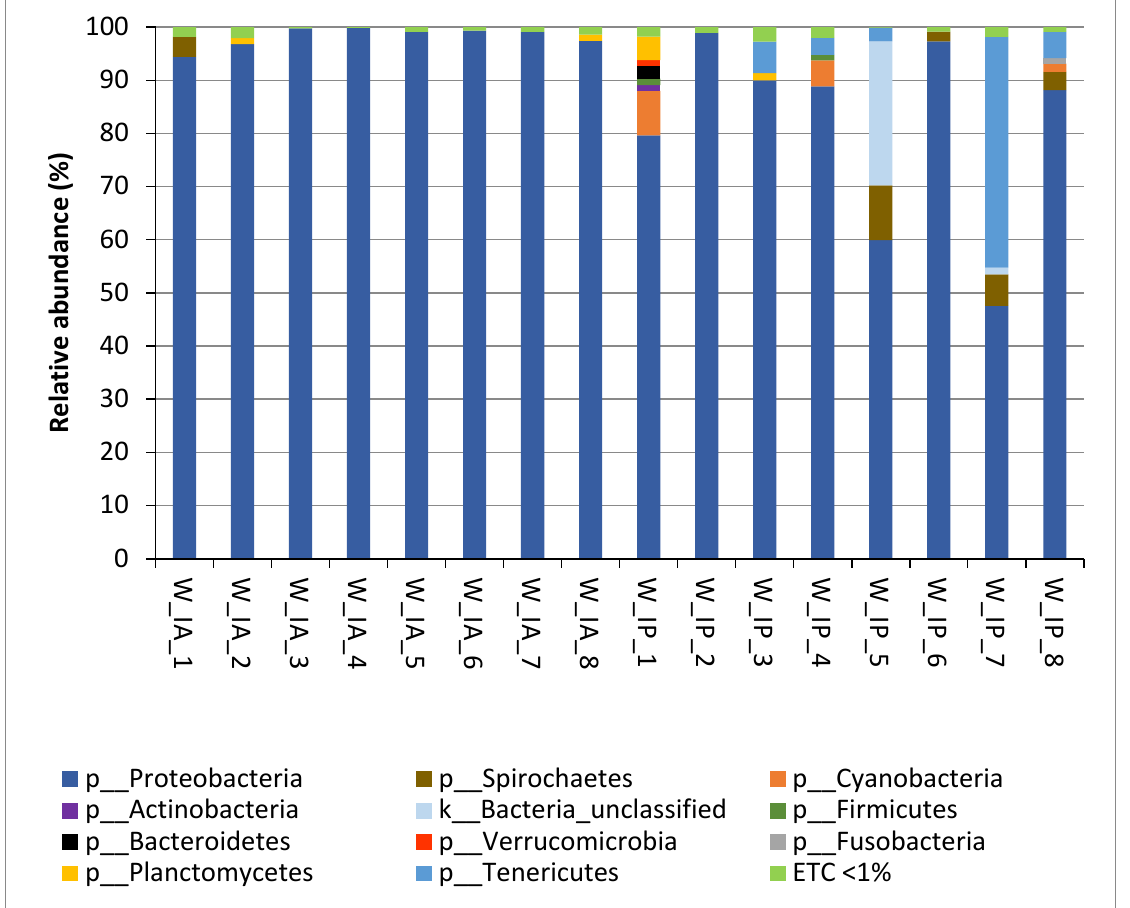
Figure 2. Relative abundance (percentage) at phylum level for each sample of intestinal microbiota from anterior and posterior sections of wild C. labrosus . In the figure, W_IA corresponds to the anterior intestinal section of wild fish, and W_IP corresponds to the posterior intestinal section of wild fish. ETC: phylum <1%.